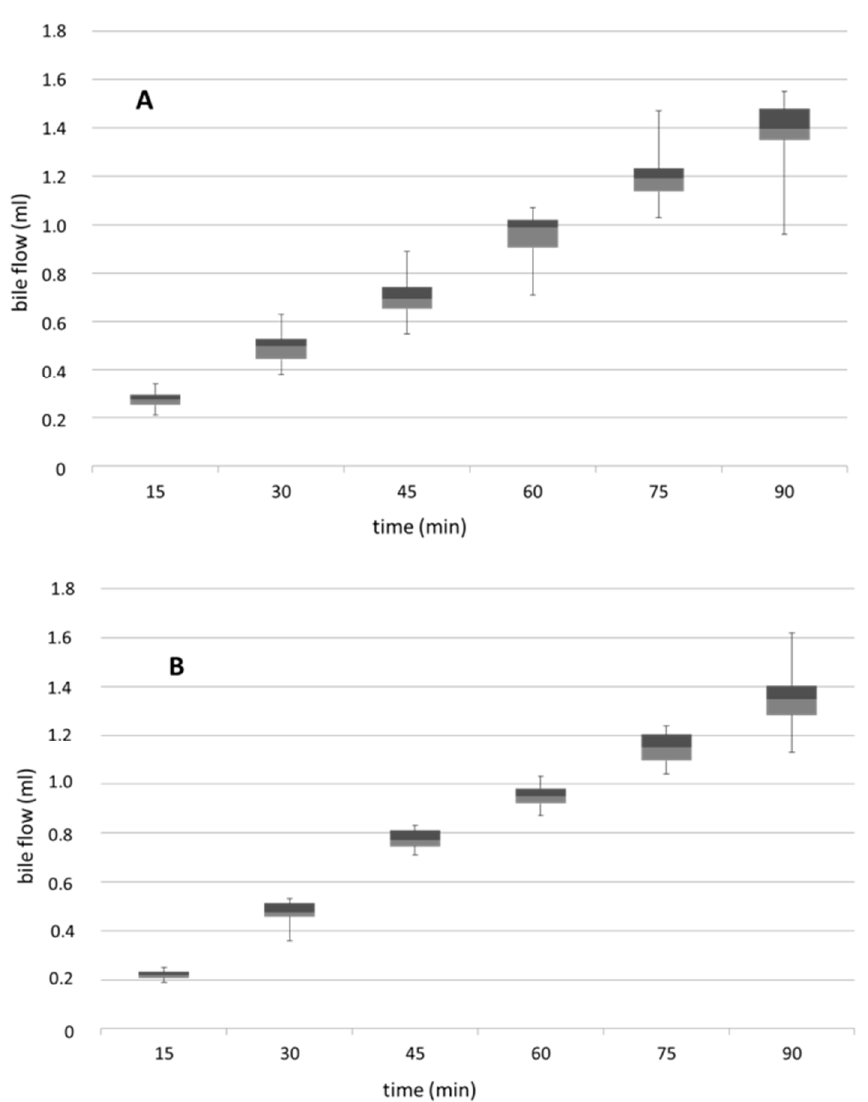
Figure 4. Biliary flow measured in control (Panel A ) and PNP-perfused (Panel B ) rats measured in 90 min perfusion of 500 µM PNP in the small intestine (proximal jejunum). Data represent the mean ± S.D. of eight rats.